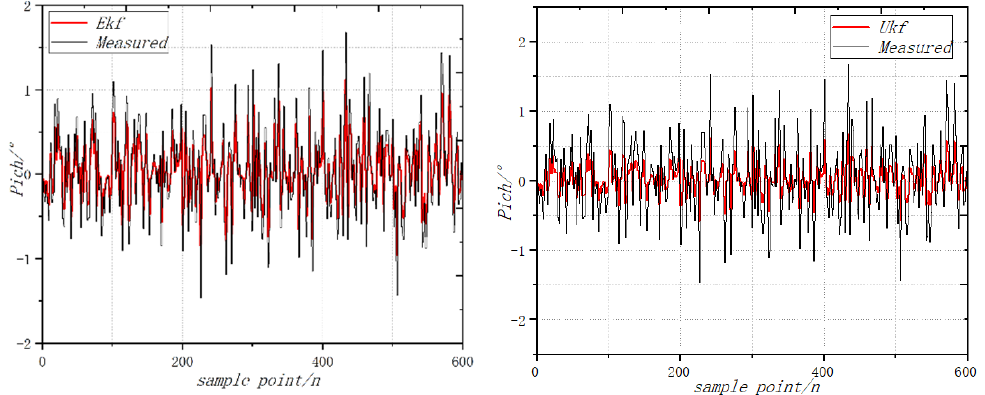
Figure 8. Variation curve of vibration acceleration in pitching motion.